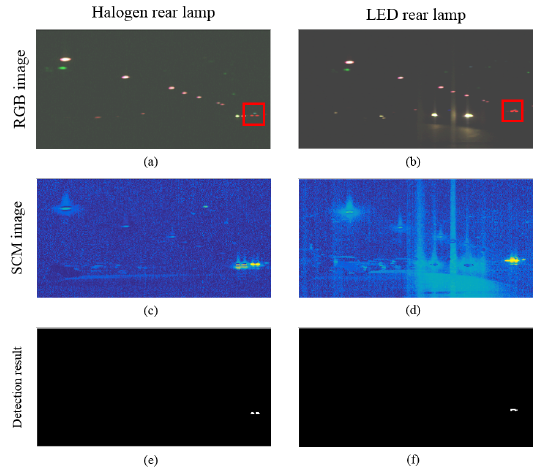
Figure 18. Comparison of the detection of each rear lamp, such as halogen and LED: ( a ) RGB composite image acquired from a halogen lamp; ( b ) RGB composite image acquired from a LED lamp; ( c ) SCM result for the hyperspectral image from a halogen lamp; ( d ) SCM result for the hyperspectral image from a LED lamp; ( e ) detection result by thresholding to SAM image from a halogen lamp; ( f ) detection result by thresholding to SAM image from a LED